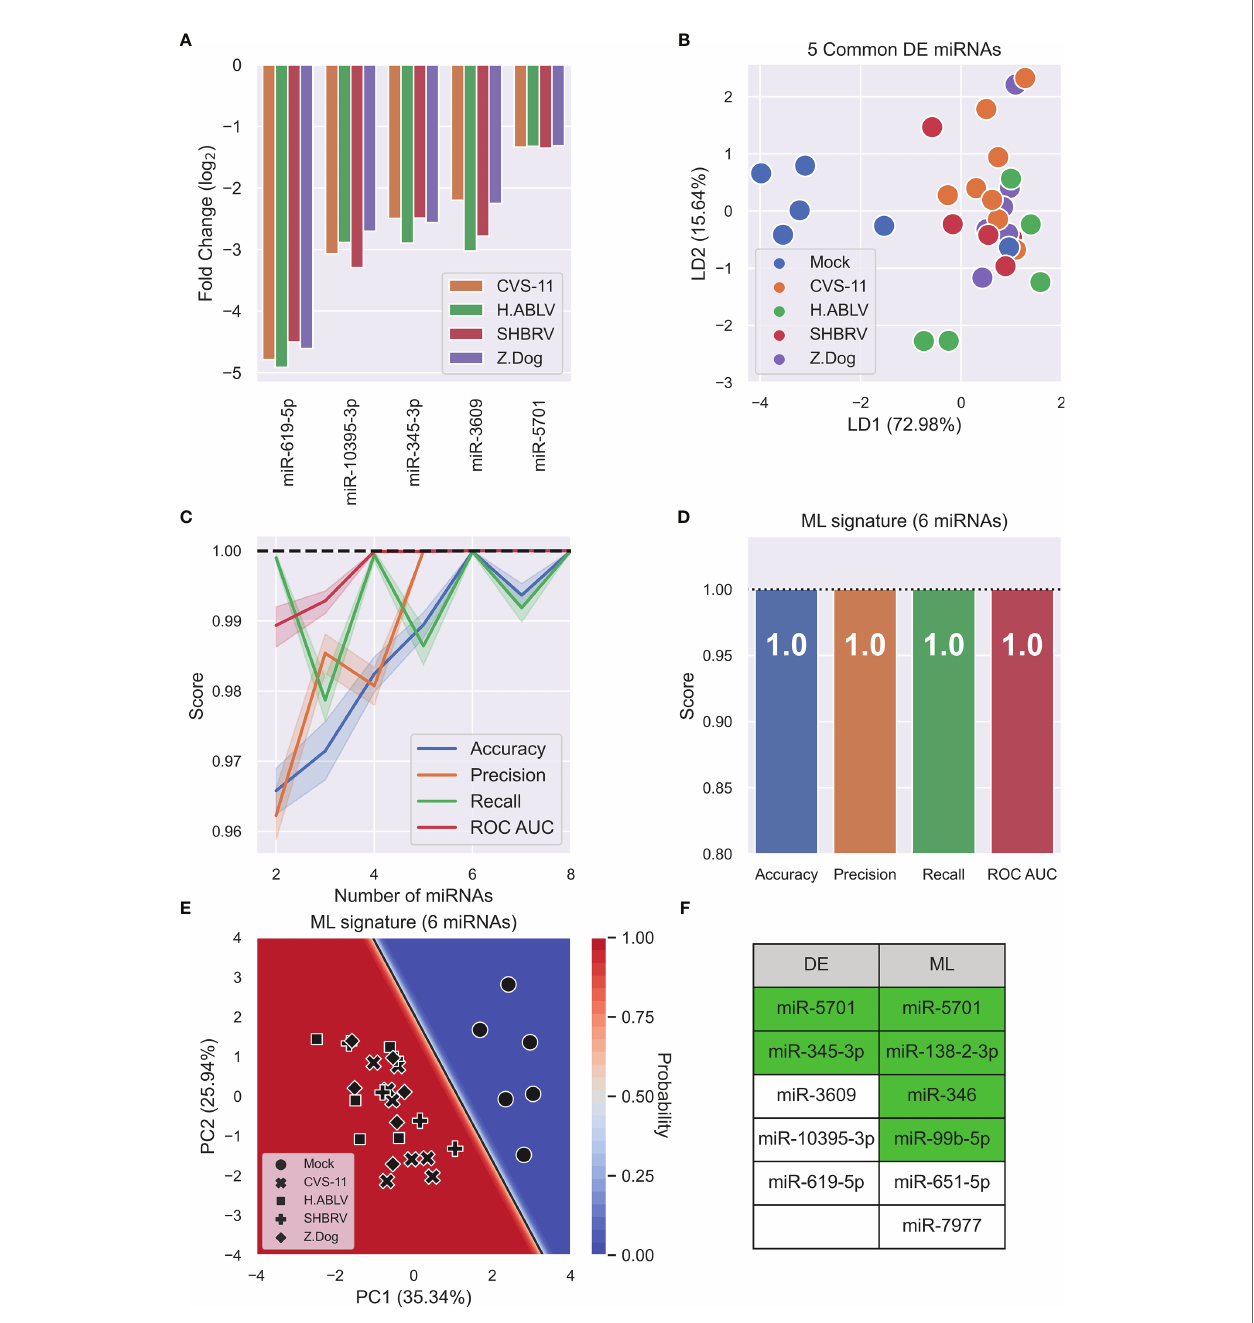
FIGURE 3 | Lyssavirus infection results in cellular miRNA changes. (A) Fold change barplot of differentially expressed HDF51i-509 neural miRNAs (adjusted p-value < 0.05) common to CVS-11 (orange, n = 8), H.ABLV (green, n = 5), SHBRV (red, n = 5), and Z.Dog (purple, n = 6) compared with Mock infection (n = 6). All sample numbers are technical replicates obtained from three separate biological experiments. (B) Linear discriminant analysis (LDA) scatterplot using the 5 common DE miRNAs. Groups are Mock infection (blue), CVS-11 (orange), H.ABLV (green), SHBRV (red), and Z.Dog (purple). (C) Feature (miRNA) selection line plot showing the impact of increasing numbers of miRNAs on the performance of a logistic regression model. MicroRNAs were selected using recursive feature elimination to identify the most important miRNAs. Each combination of miRNAs was randomly assessed 1,000 times. Shaded areas are the 95% CI, and the dotted line is a perfect (100%) score. (D) Barplot showing the average performance metrics of the 6-miRNA ML signature in classifying mock infected and lyssavirus-infected neural cell culture. Error bars are the 95% CI after 1,000 random iterative assessments. Dotted line is 100%. (E) Decision boundary graph showing the logistic regression decision point (solid black line) and the probability neural cells are infected with lyssavirus (blue to red shading). Datapoints are mock infection (circles), CVS-11 (crosses), H.ABLV (squares), SHBRV (plusses), and Z.Dog (diamonds) neuronal cell samples. (F) Table listing miRNAs highlighted by differential expression (DE) and machine learning (ML) analysis. MicroRNAs highlighted in green have been previously associated with neuronal cell function, altered behavior, or